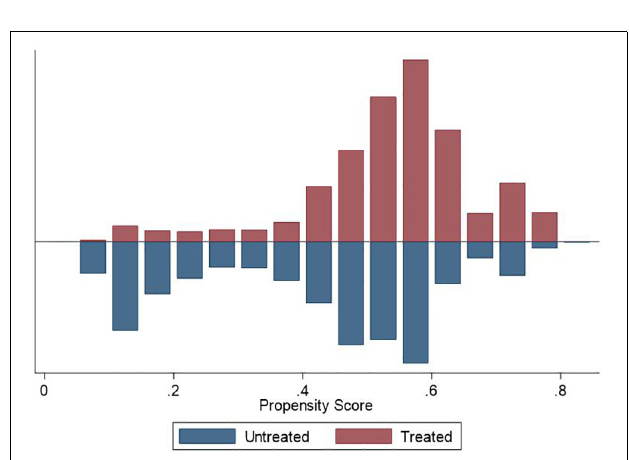
FIGURE 2 | Density distribution of treated and untreated observations (Fertility ≥ two children).